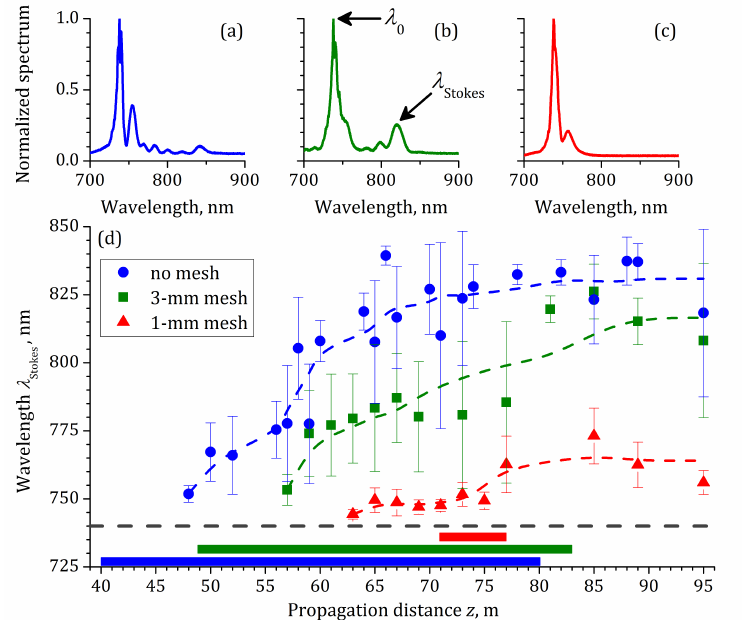
Figure 5. Normalized pulse spectra measured at z = 94 m for different modulation regimes: without modulation (( a ), blue), using 3 mm (( b ), green) and 1 mm (( c ), red) meshes. ( d ) Dependencies of the position λ Stokes of the longest-wavelength maximum in the spectrum on the propagation distance z for all three cases. Dashed line in ( d ) indicates pulse central wavelength λ 0 . Color bands in lower part of ( d ) show the range where the laser pulse triggered the electric